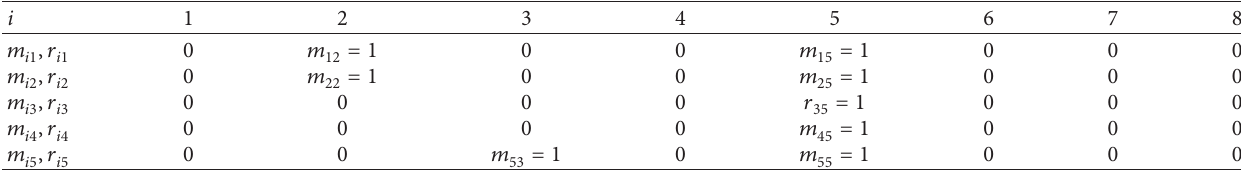
Table 4: The optimal maintenance planning.